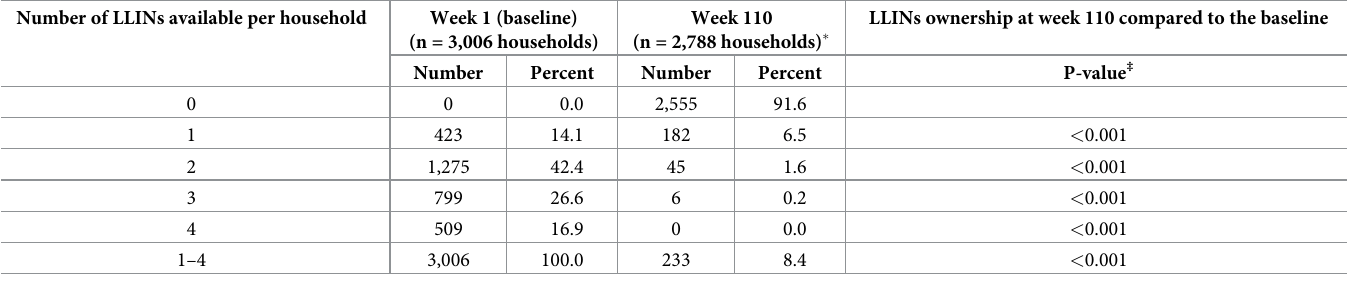
Table 2. Number and percentage of households with long-lasting insecticidal nets at baseline and after 110 weeks, Ethiopia November 2016. Number of LLINs available per household